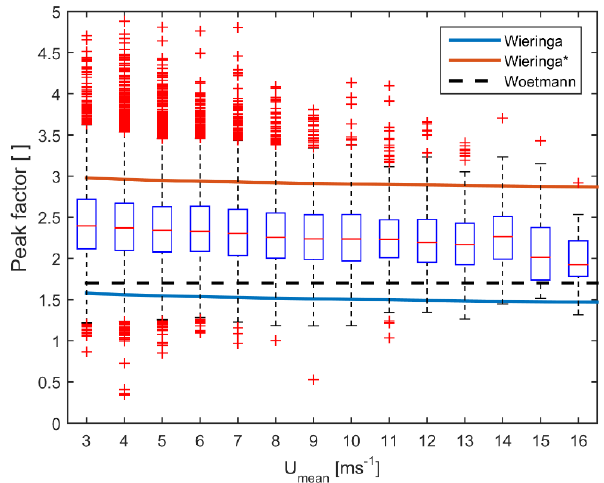
Figure 9. Box plot of gust peak factor ( k peak ) estimates at 60ma.g.l. from all nine towers as a function of U mean . Also shown are estimates from Eq. (3) (Wieringa, 1973), a revised empirical function in which the leading term in Eq. (3) is increased from 1.0 to 2.4 (Wieringa ∗ ) and a constant value of 1.7 (Woetmann Nielsen and Petersen,